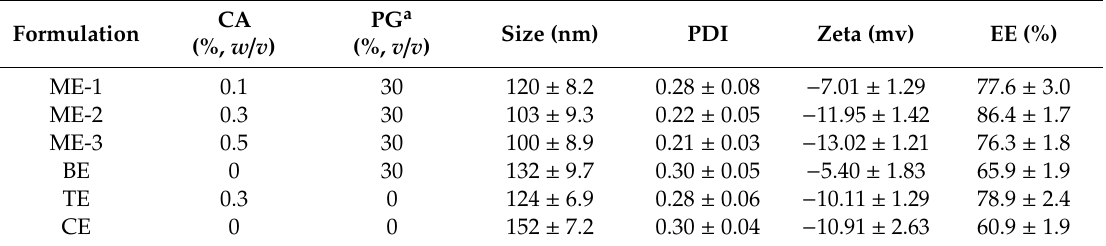
Table 1. Composition of the di ff erent ethosome formulations and their physico-chemical properties, as well as the drug entrapment e ffi